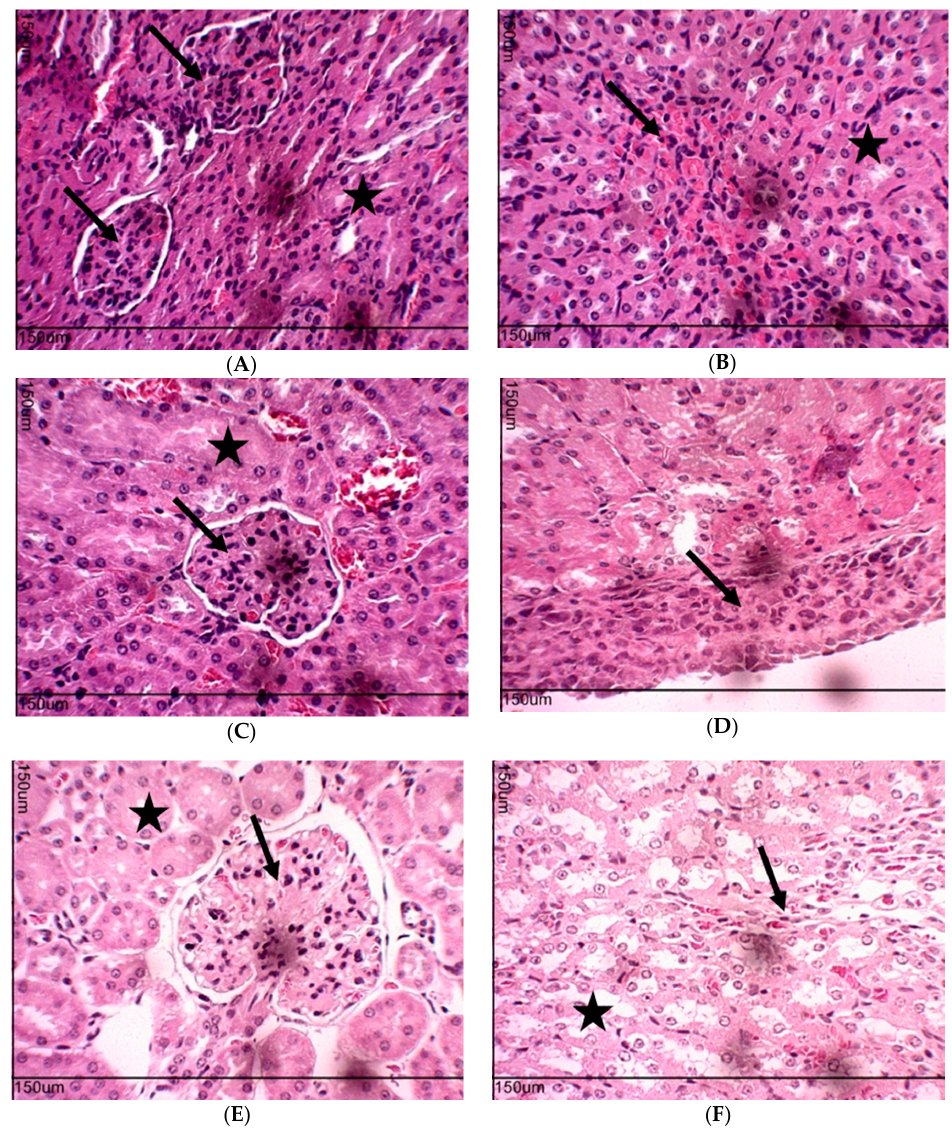
Figure 7. Histopathology of the kidneys of different groups: ( A ) Control, cortical region, renal glomerulus (arrow) and cortical labyrinth (star). ( B ) Control, medullary region, collecting tubules (star), loop of Henle and vessels straight (arrow). ( C ) Group 5-FU, cortical region, glomerulus (arrow) and cortical labyrinth (star). ( D ) Group HE-02 (12.5 mg/kg), subcapsular region, cell infiltrate (arrow). ( E ) Group HE-02 (12.5 mg/kg), cortical region, renal corpuscle (arrow) and cortical labyrinth (star). ( F ) Group HE-02 (12.5 mg/kg), medullary region, loop of Henle and medullar rays (arrow), collecting tubules (star). A, B, C, D, E and F-HE, A.T. ×400.